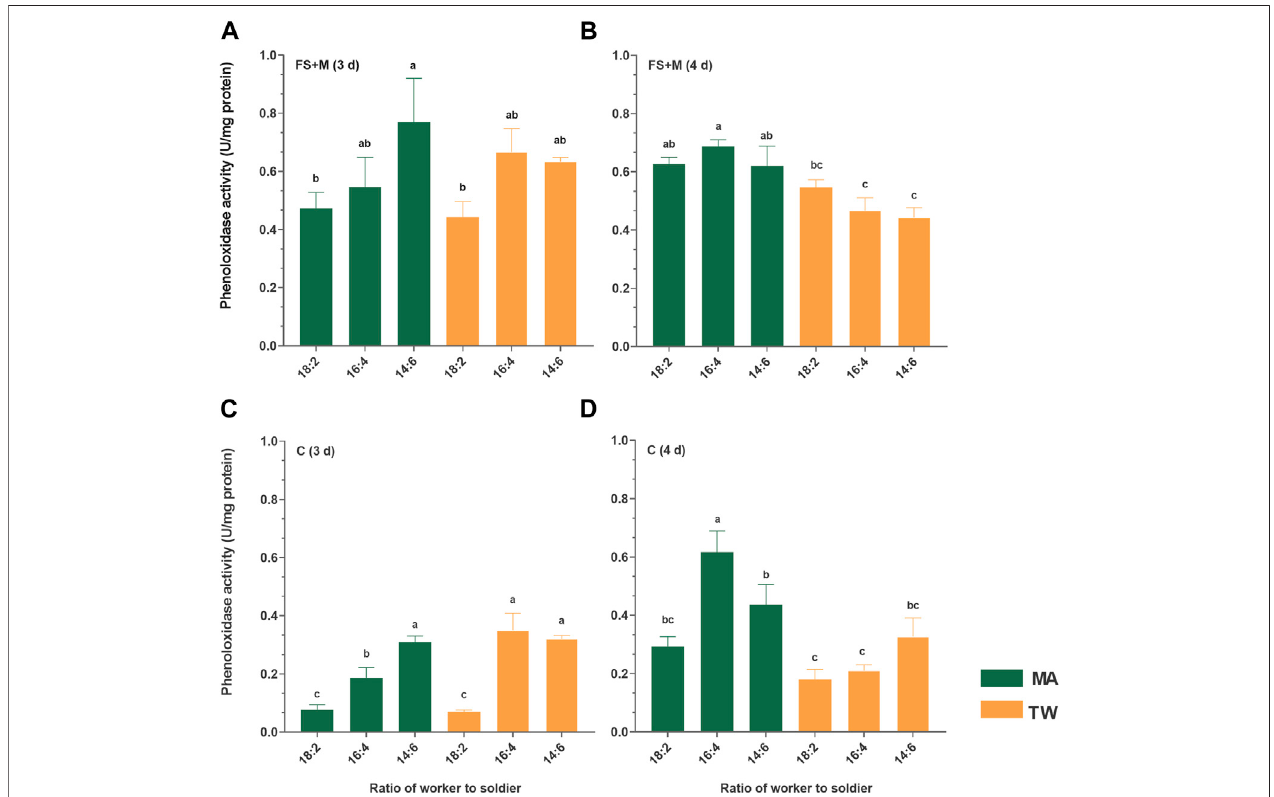
FIGURE5| Phenoloxidaseintheforegut/salivarygland+midgut(FS+M)andcuticle (C) oftheworker Coptotermesfomosanus .Errorbarsrepresentmean±SEM. Different letters indicate signi fi cant differences among the six sets of data (one-way ANOVAs, LSD, p < 0.05). The numbers before and after the colon in the abscissa represent the numbers of workers and soldiers in each group, respectively. The letters “ (A – D) ” at the top of the picture represent the identi fi ers of the four histograms respectively. MA, Metarhiziumanisopliae -infected group;TW,0.1%Tween-80-treated controlgroup; FS+M, foregut/salivary gland+midgut; Ccuticle (contained hemolymph and fat